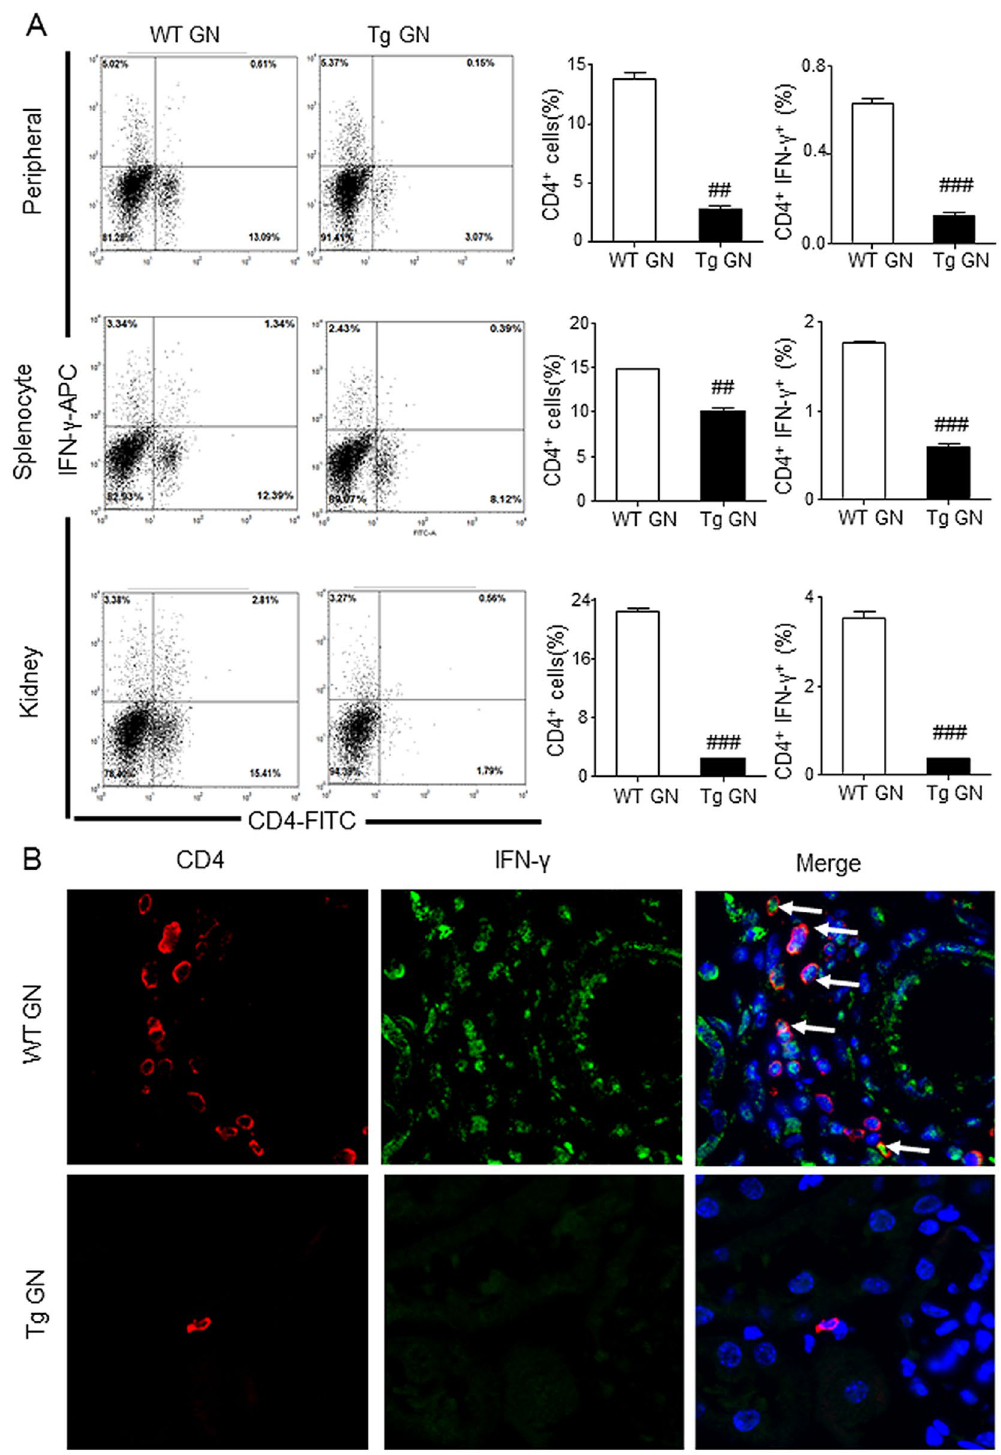
Figure 5. Systemic and renal infiltrated CD4 + IFN- γ + Th1 cells are reduced in Foxp3 Tg mice compared with WT mice. ( A ) Flow cytometric analysis of peripheral and splenic and renal infiltrated CD4 + IFN- γ + Th1 cells from diseased WT and Tg mice. ( B ) Infiltration of CD4 + IFN- γ + Th1 in the inflamed kidney tissues on Day 14 after disease induction was identified by two-color immunofluorescence with IFN- γ + (green) and CD4 + (red). Examples of CD4 + IFN- γ + Th1 cells are indicated by white arrows. Each bar represents mean ± SEM. ### p < 0.001 compared with the WT mice. n = 3 mice per group. Original magnification 400 × ( B